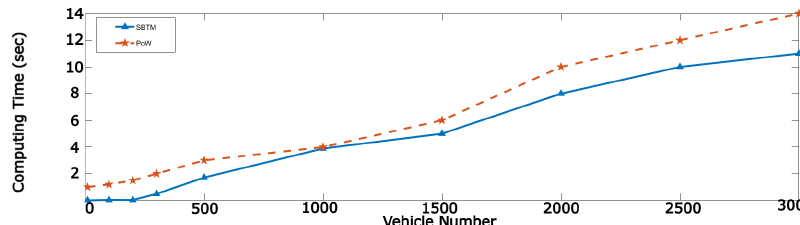
Figure 14. Comparison vehicles calculation time between Sharding and